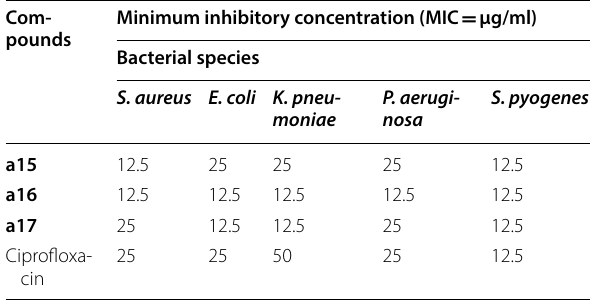
Table 8 Antibacterial activity results of compounds (a15– a17)